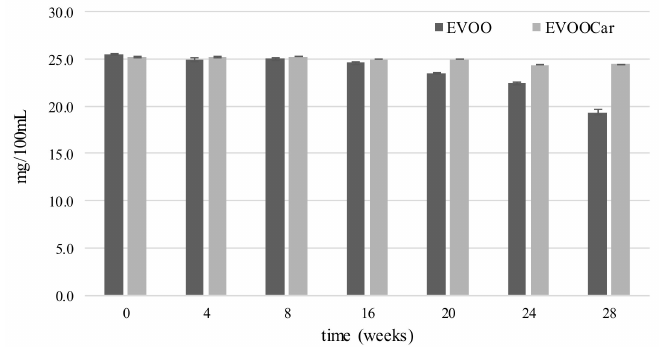
Figure 4. Trend of α -tocopherol content (mg / 100 mL, mean values) of EVOO and EVOOCar during long-term storage. Error bars refer to the standard deviations ( n =